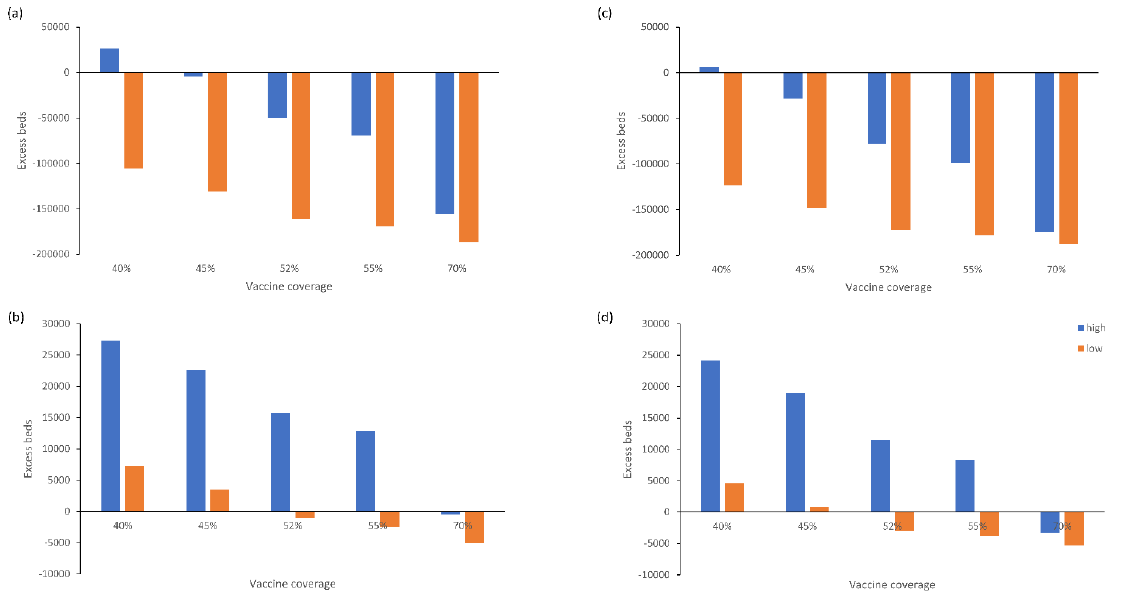
Figure 1. Excess ( a ) acute and ( b ) ICU beds used for treatment of COVID-19 and influenza patients by vaccine coverage (base case scenario: QIVe for all age groups) and ( c ) acute and ( d ) ICU beds used for treatment of COVID-19 and influenza patients by vaccine coverage (scenario 2: QIVc for 6 months to 64 years, aQIV for ≥ 65 years) during high and low incidence influenza seasons.